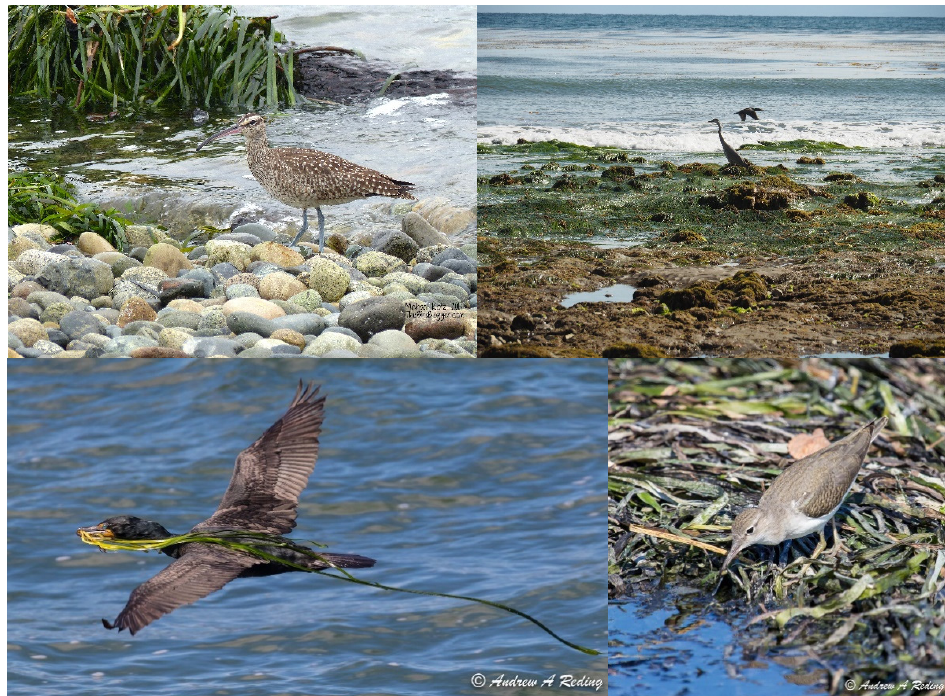
Figure 3. Significant photographic evidence of the links between bird foraging and seagrass can be found through searching through imagery available on the website flikr.com (photo source: Flikr.com (accessed on 1 July 2021)).